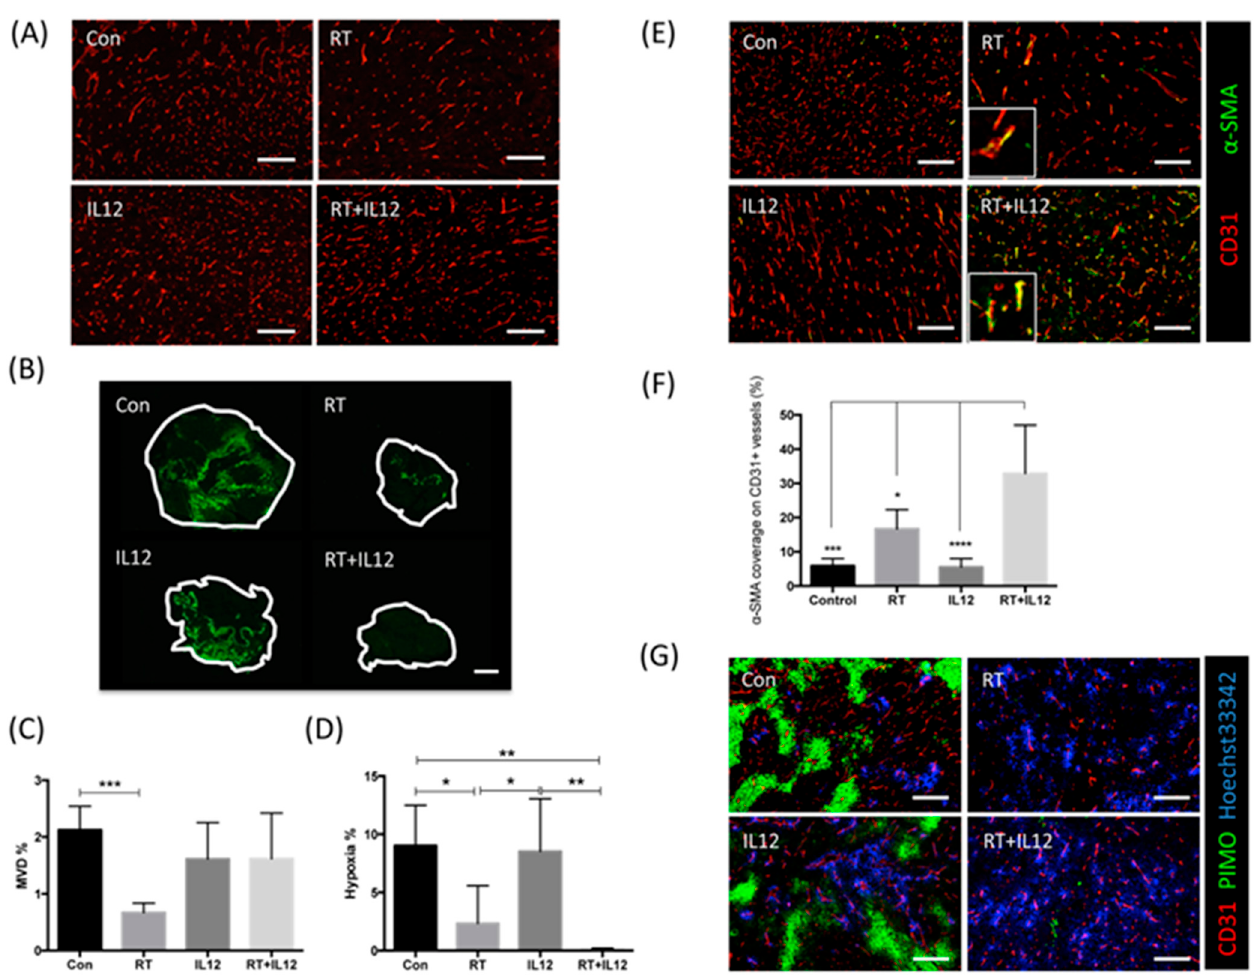
Figure 3. Combined modality therapy promoted the vascular maturation and function. Representative images of tumors stained by ( A ) CD31 and ( B ) PIMO to identify vessels and tumor hypoxia area. Scale bar: 200 µ m and 1 mm in 3A and 3B, respectively. ( C , D ) The quantification of microvascular density (MVD) and hypoxia region was analyzed from the section of whole tumor area in each group. Each group had at least four samples. ( E ) Representative images of the coverage of CD31+ vessels (red) by α -SMA+ pericyte (green). Scale bar: 200 µ m. ( F ) The percentage of pericyte coverage was examined under 100x magnification field in each section. Each sample had at least five fields for quantification. Each group had at least four samples. ( G ) Representative images of vessel (red), hypoxia (green), and blood perfusion (blue) in tumors. The blood perfusion was presented by Hoechst33342 signal. Scale bar: 200 µ m. * p < 0.05, ** p < 0.01, *** p < 0.001, **** p <